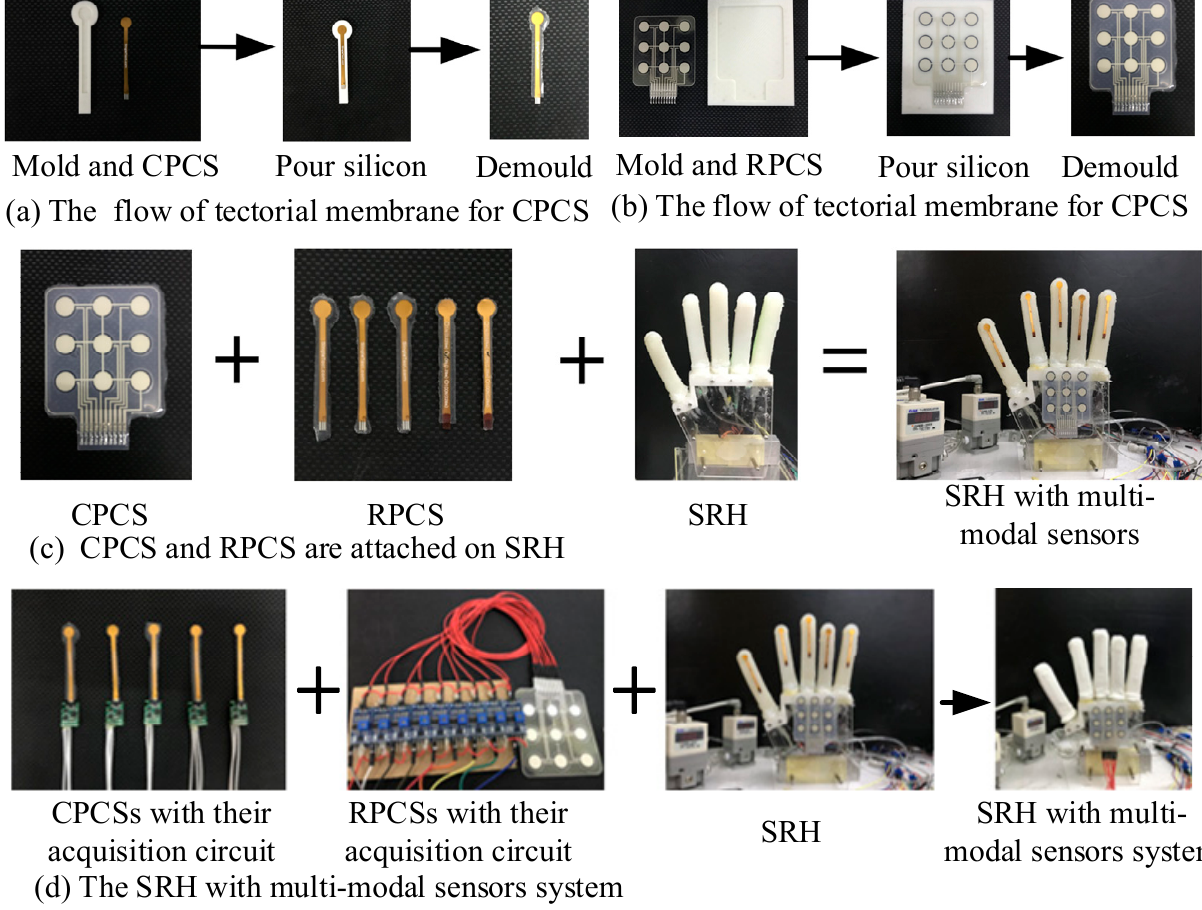
Figure 3. The processing flow of CPCS and RPCS attached to SRH. ( a ) The flow of tectorial membrane for CPCS. ( b ) The flow of tectorial membrane for CPCS. ( c ) CPCS and RPCS are attached on SRH. ( d ) The SRH with multimodal sensor system.